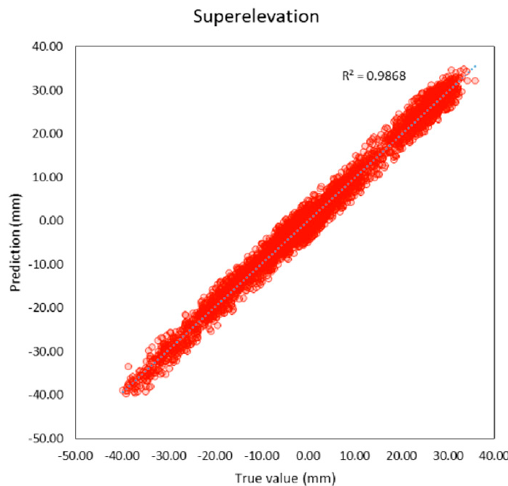
Figure 5. Correlation between true and predicted values of superelevation.